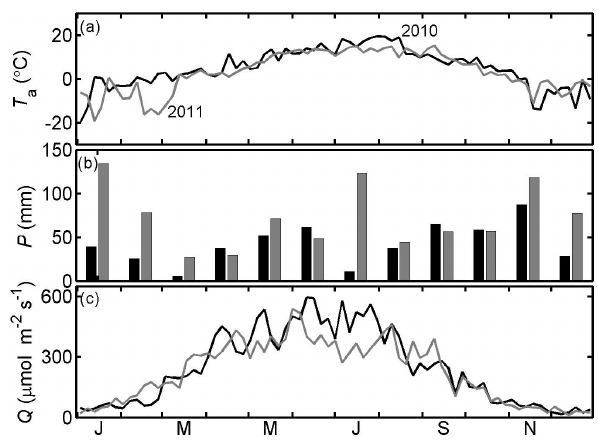
Fig. 2. Climate data at MPB-09 for 2010 and 2011 with (a) 5-day averaged air temperature ( T a ), (b) monthly total precipitation ( P) and (c) 5-day averaged downwelling PAR ( Q) .